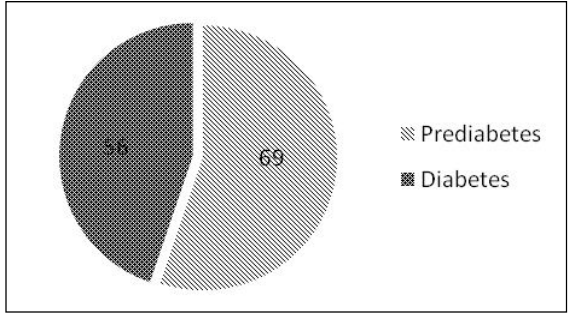
Figure 2. Number of patients in